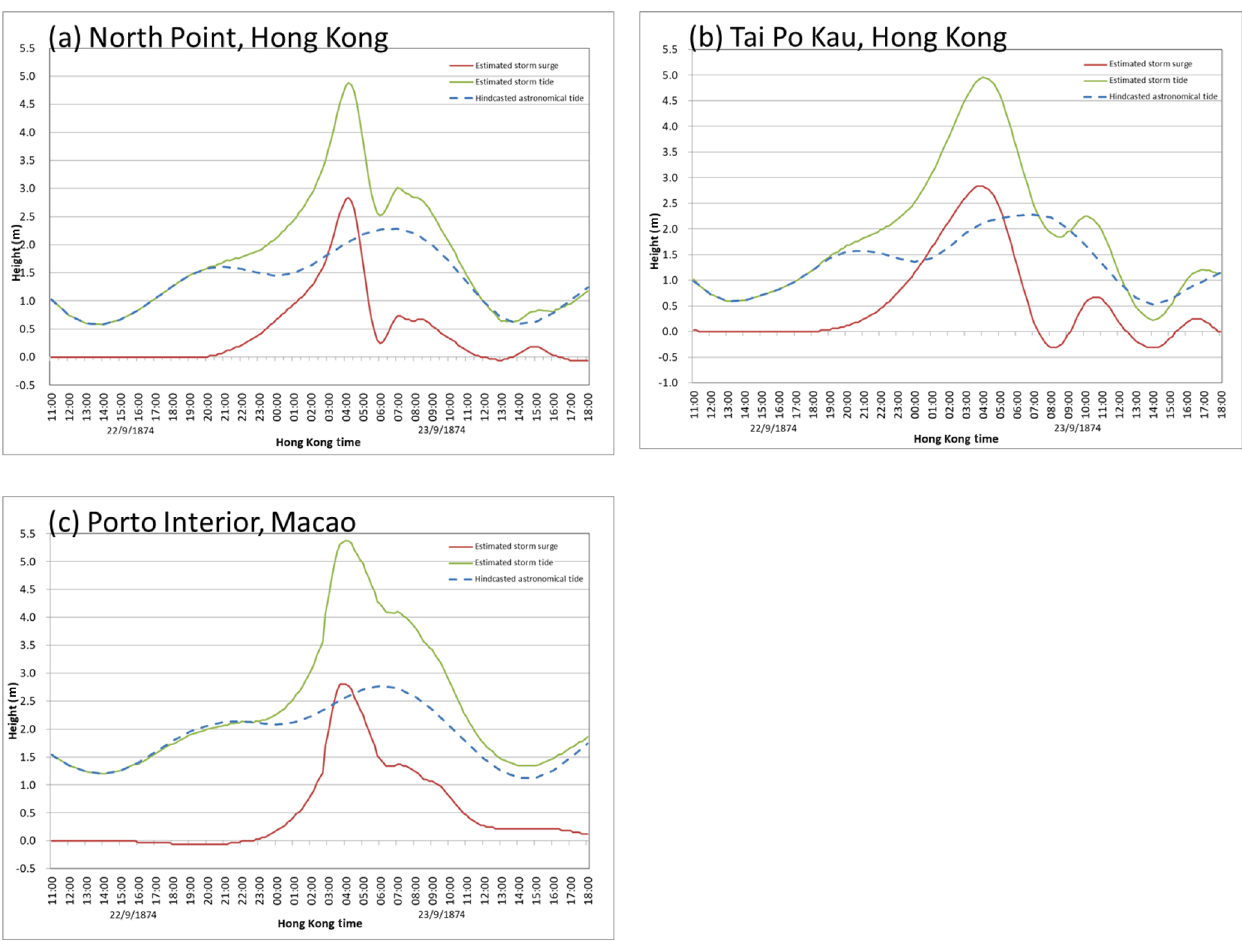
Figure 7. Time series of the hindcasted astronomical tide and estimated storm tide above the Hong Kong Chart Datum and the estimated storm surge at (a) North Point and (b) Tai Po Kau in Hong Kong from 11:00 on 22 September to 18:00 on 23 September 1874. Time series of the hindcasted astronomical tide and estimated storm tide above the Macao Chart Datum and the estimated storm surge at (c) Porto Interior in Macao from 11:00 on 22 September to 18:00 on 23 September 1874. The estimated storm tide is the sum of the estimated storm surge and the astronomical